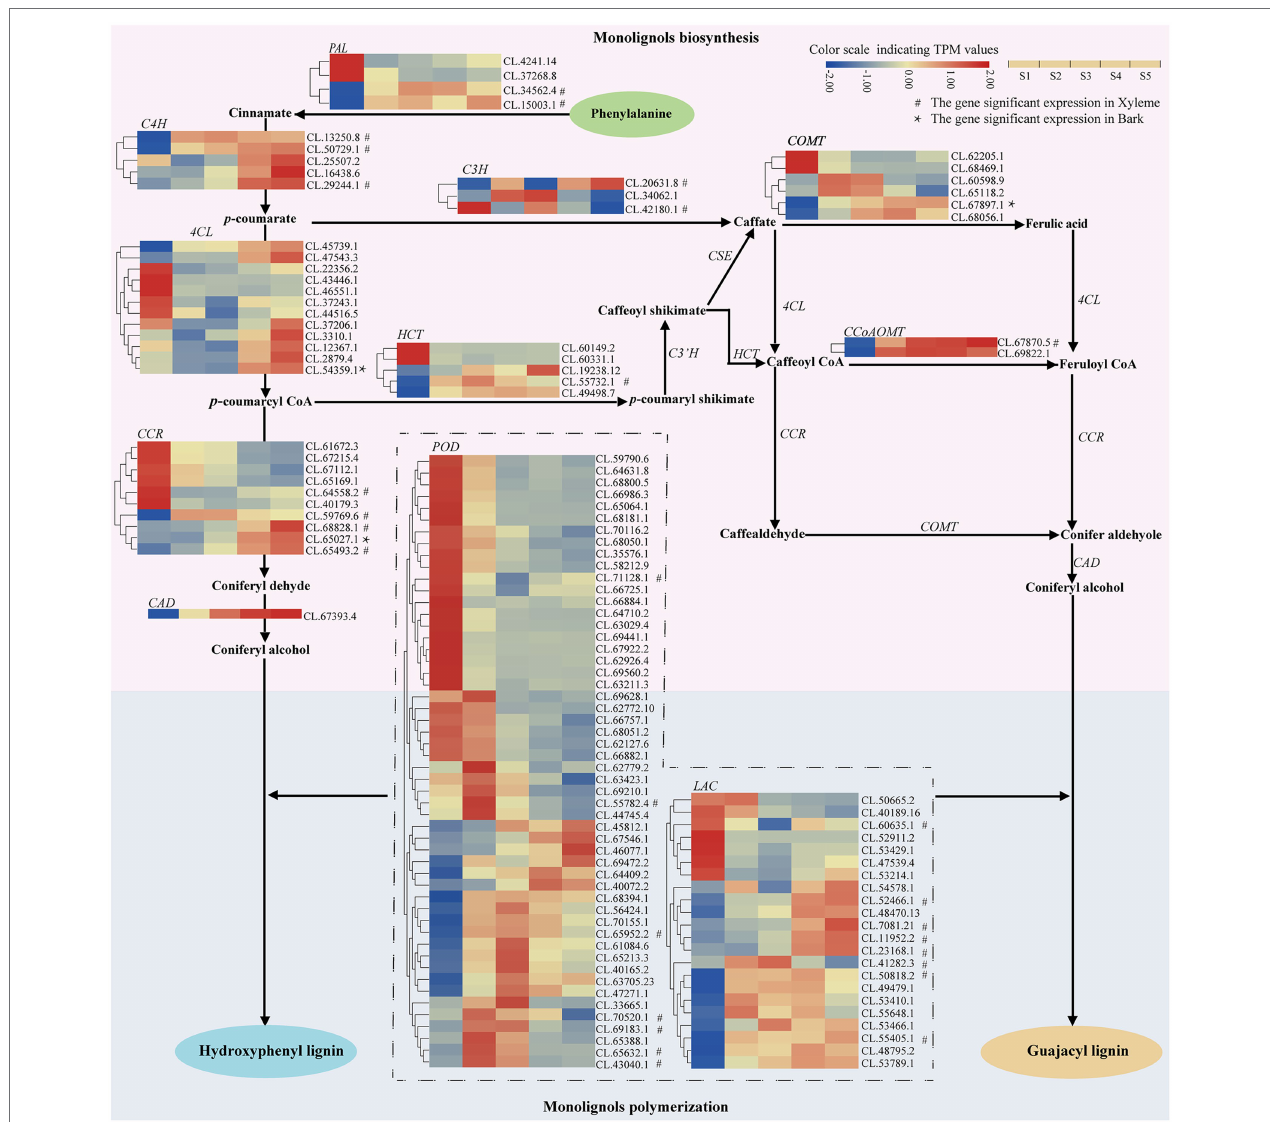
FIGURE 3 | Heatmap depicting the expression profiles of DEGs involved in lignin biosynthesis in C. lanceolata